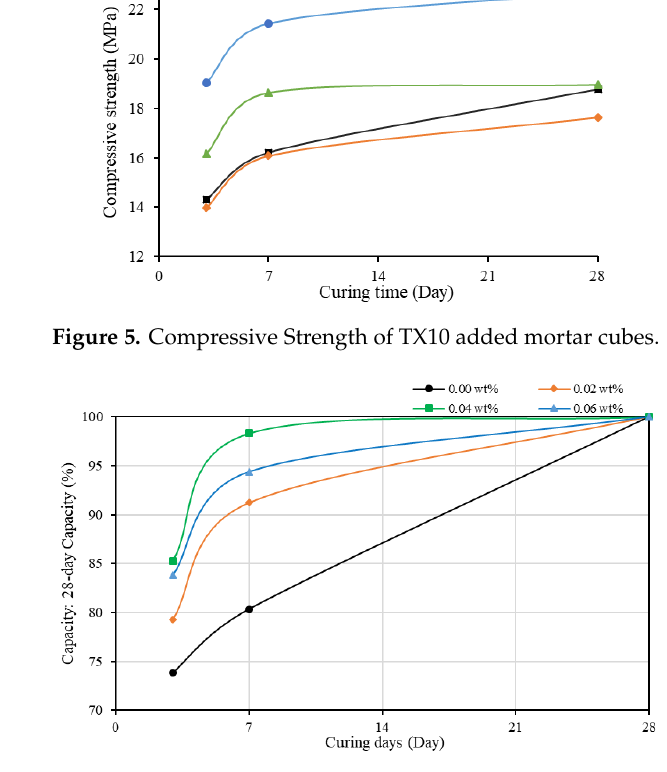
Figure 6. The evolution of the strength of mortars (SAA) as a function of curing time.